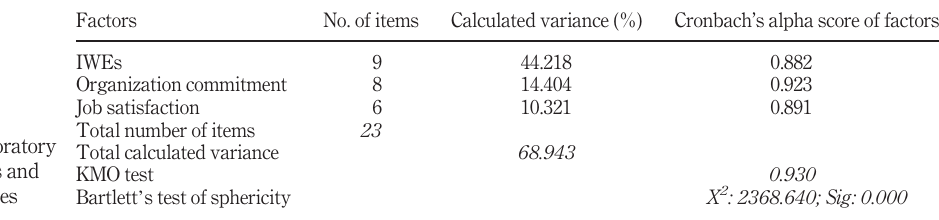
Table III. Result of exploratory factor analysis and reliability